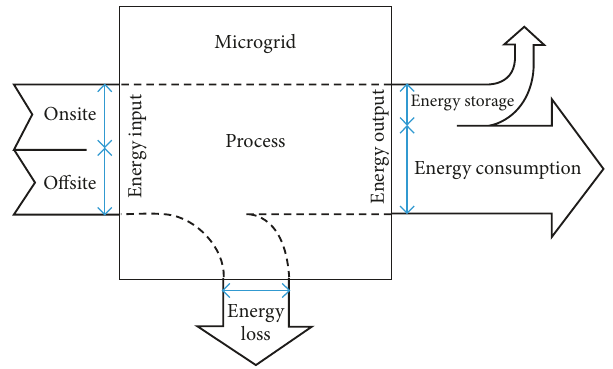
Figure 1: Energy performance in a microgrid can be evaluated by comparing the energy input to the energy